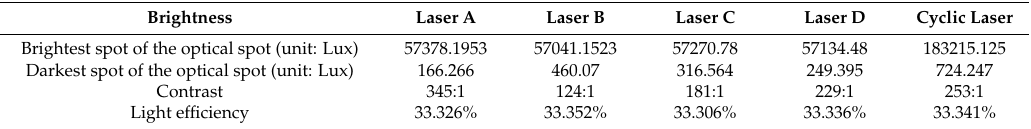
Table 8. Contrast and light efficiency for a single green laser and cyclic micro-scanning laser (liquid crystal lens with pore size of 2.0 mm and a focal length of 23 cm). Brightness Laser A Laser B Laser C Laser D Cyclic Laser Brightest spot of the optical spot (unit: Lux) 1522,387.88 1511,813.25 1547,229.63 1556,919 4390,922 Darkest spot of the optical spot (unit: Lux) 4587.92 4175.74 4912.65 4418.53 35,573.425 Contrast 332:1 362:1 315:1 352:1 123:1 Light efficiency 23.056% 23.093% 23.568% 23.541% 23.296% Table 9. Contrast and light efficiency for a single blue laser and cyclic micro-scanning laser (liquid crystal lens with pore size of 2.0 mm and a focal length of 23 cm). Brightness Laser A Laser B Laser C Laser D Cyclic Laser Brightest spot of the optical spot (unit: Lux) 57378.1953 57041.1523 57270.78 57134.48 183215.125 Darkest spot of the optical spot (unit: Lux) 166.266 460.07 316.564 249.395 724.247 Contrast 345:1 124:1 181:1 229:1 253:1 Light efficiency 33.326% 33.352% 33.306% 33.336%